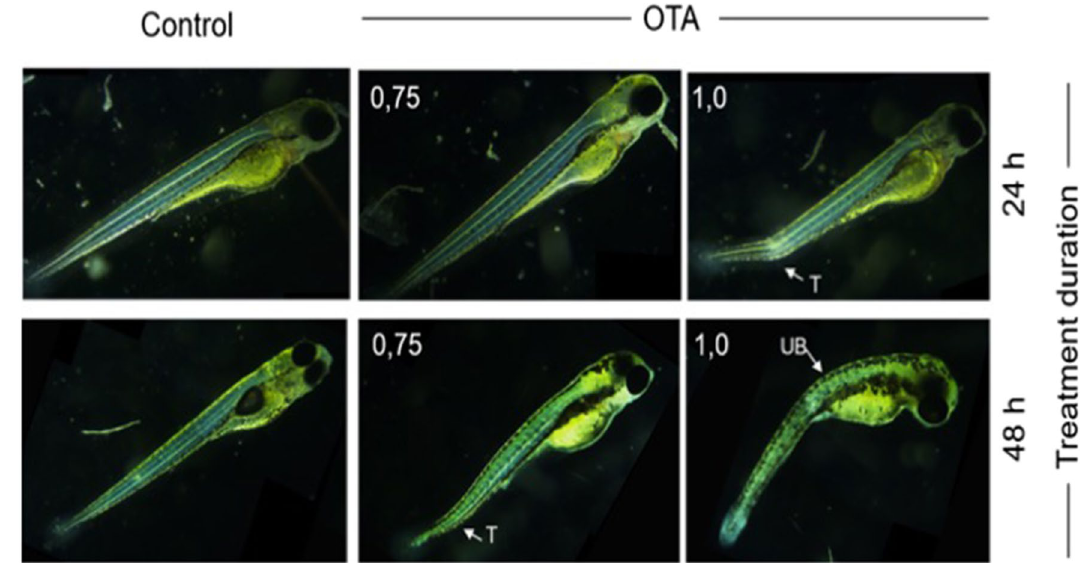
Figure 2. Representative images showing developmental deformities of zebrafish embryos. The embryos were exposed (at 72 hpf) to 0.75 µM or 1.0 µM OTA for a duration of 24 h or 48 h, compared to untreated (i.e., Control) embryos. Images were taken at 96 hpf (i.e., 24 h, upper) and 120 hpf (i.e., 48 h, lower). Deformities include bending of upper body (UB) and tail (T). Scale bar = 500